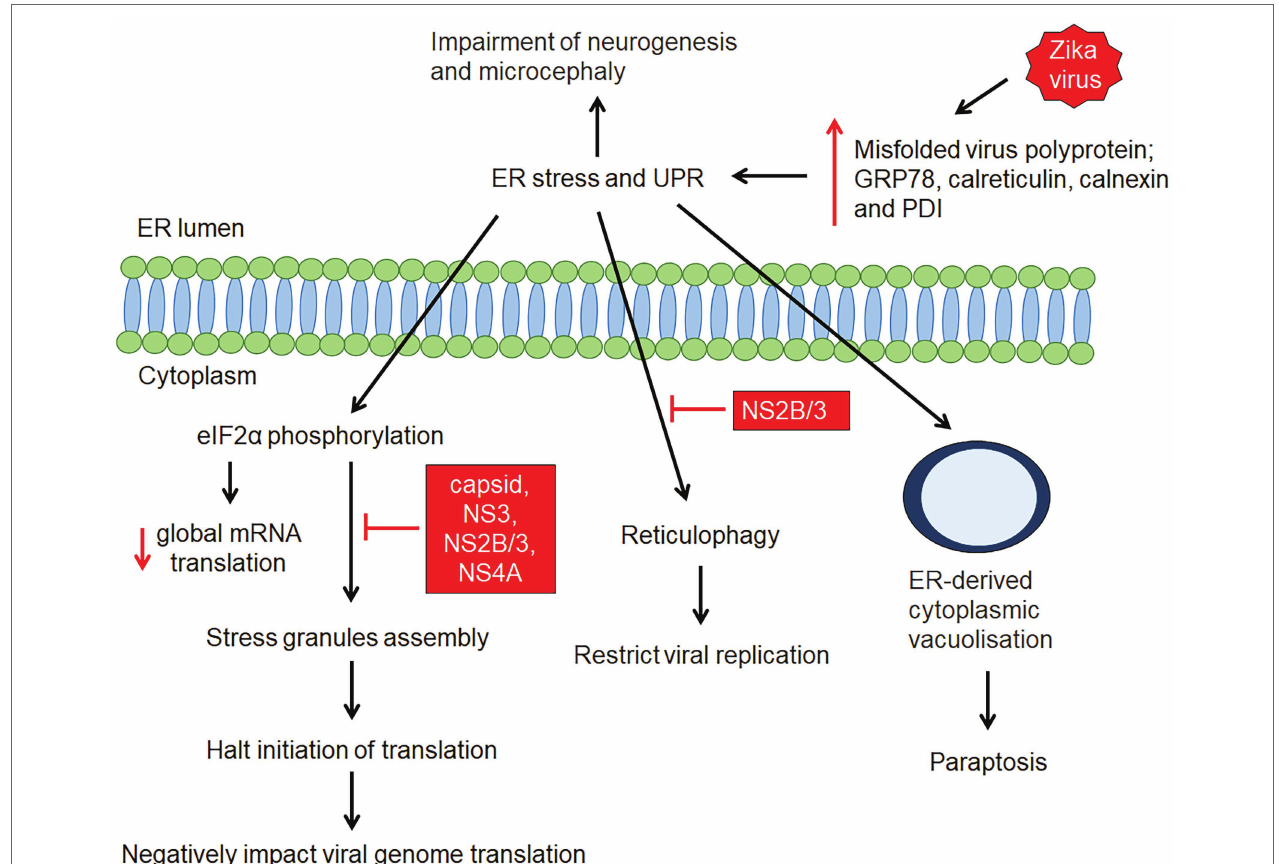
FIGURE 3 | ZIKV-induced endoplasmic reticulum (ER) stress and unfolded protein response. ZIKV infection causes structural changes of the ER as a result of accumulation of misfolded/unfolded ZIKV proteins and remodelling of the ER structure for viral RNA replication. The accumulation of misfolded/unfolded ZIKV proteins and the increase in ER protein-folding capacity triggers ER stress and activates the unfolded protein response (UPR), resulting in elevation of GRP78, calnexin, calreticulin, and protein disulfide isomerase (PDI). This is followed by initiation of several mechanisms such as global protein translation, stress granule assembly, reticulophagy and cytoplasmic vacuolisation. Zika virus proteins (capsid, NS3, NS2B/3 and NS4A proteins) has shown to, suppress SGs assembly, while NS2B/3 has shown to inhibit reticulophagy which facilitate continuous viral